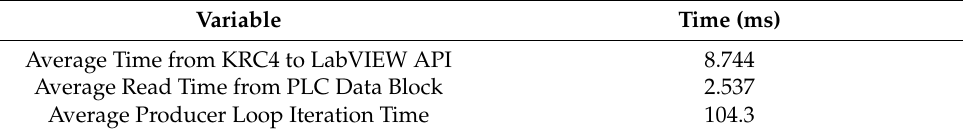
Table 1. Time required for a data block transmission within the local interfacing network.